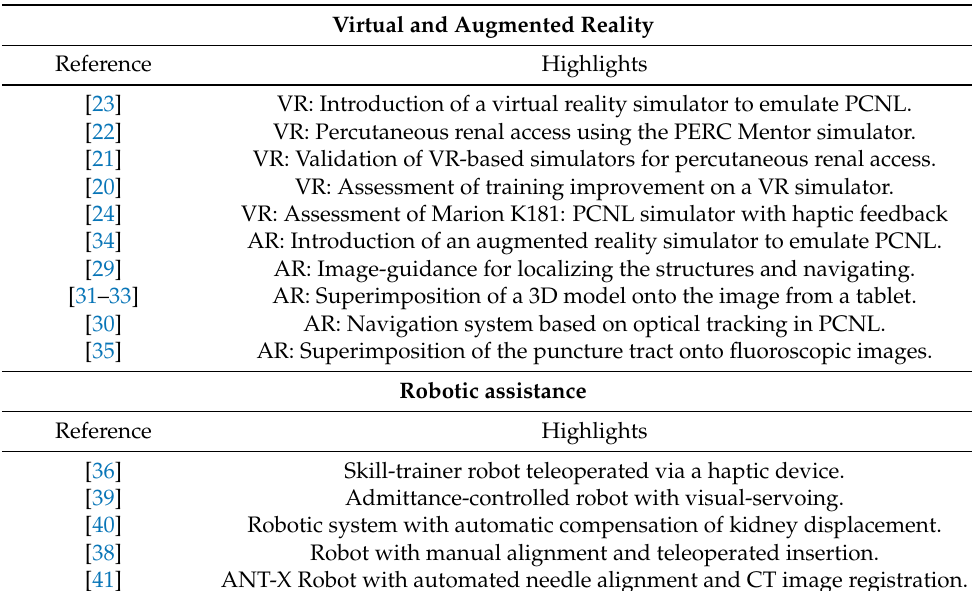
Figure 2. The categories of robotic assistance for PCNL surgery. Table 1. Latest literature on virtual and augmented reality and robotic assistance in